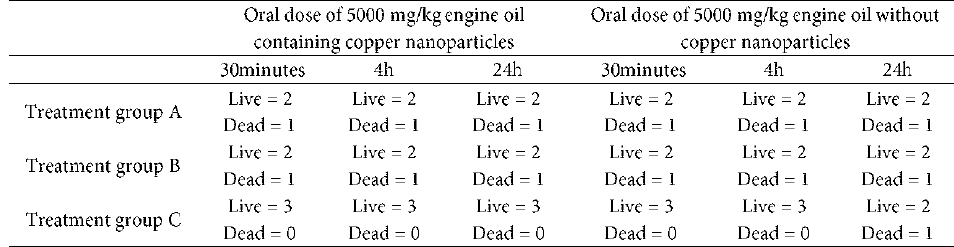
Table 1. Oral dose of 5000 mg / kg engine oil containing and without copper nanoparticles in three treatment groups at 30 minutes, 4 hours and 24